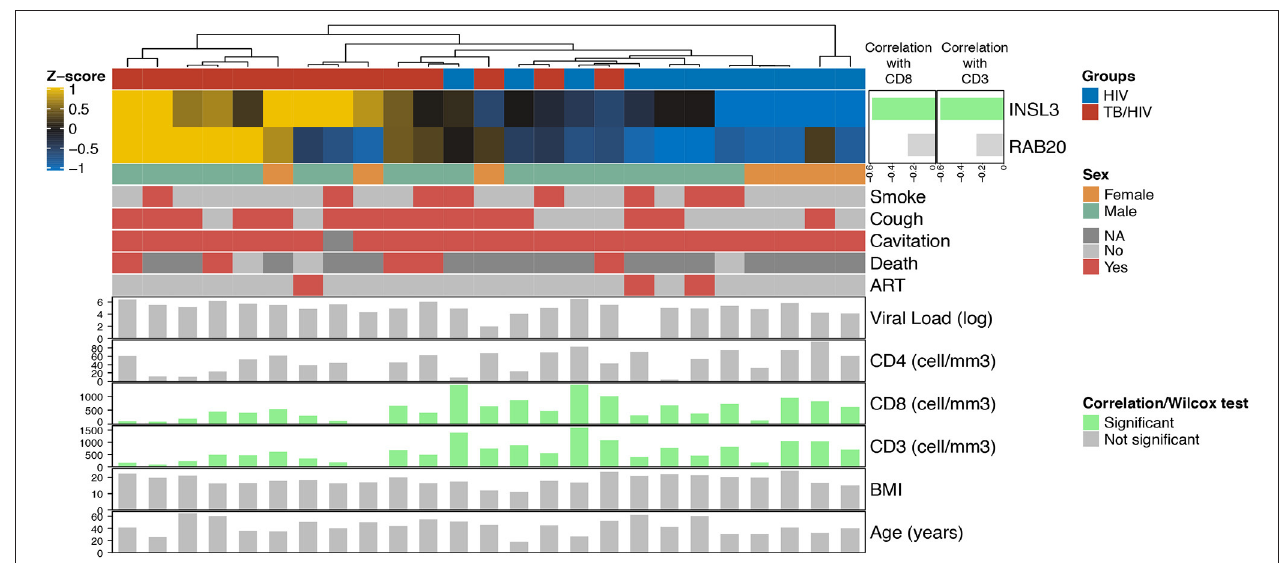
FIGURE 3 | Heatmap showing the relationship between Decision-tree gene expression and clinical characteristics in the India cohort. The top horizontal bar corresponds to cases (red) and controls (blue). The side bar plot shows the Spearman correlation value measuring the association between INLS3 and RAB20 expression and CD8 + and CD3 + cell count; green bars indicate a significant association. The lower horizontal bars correspond to female (orange) vs. male (green) followed presence (red) vs. absence (light gray) of participant characteristics; dark gray indicates no information available. The bottom bar plots show significant (green vertical bars) and non-significant (gray vertical bars) correlations with participant characteristics, including log 2 HIV viral load; CD4 + /CD8 + /CD3 + cell counts, body mass index (BMI) and